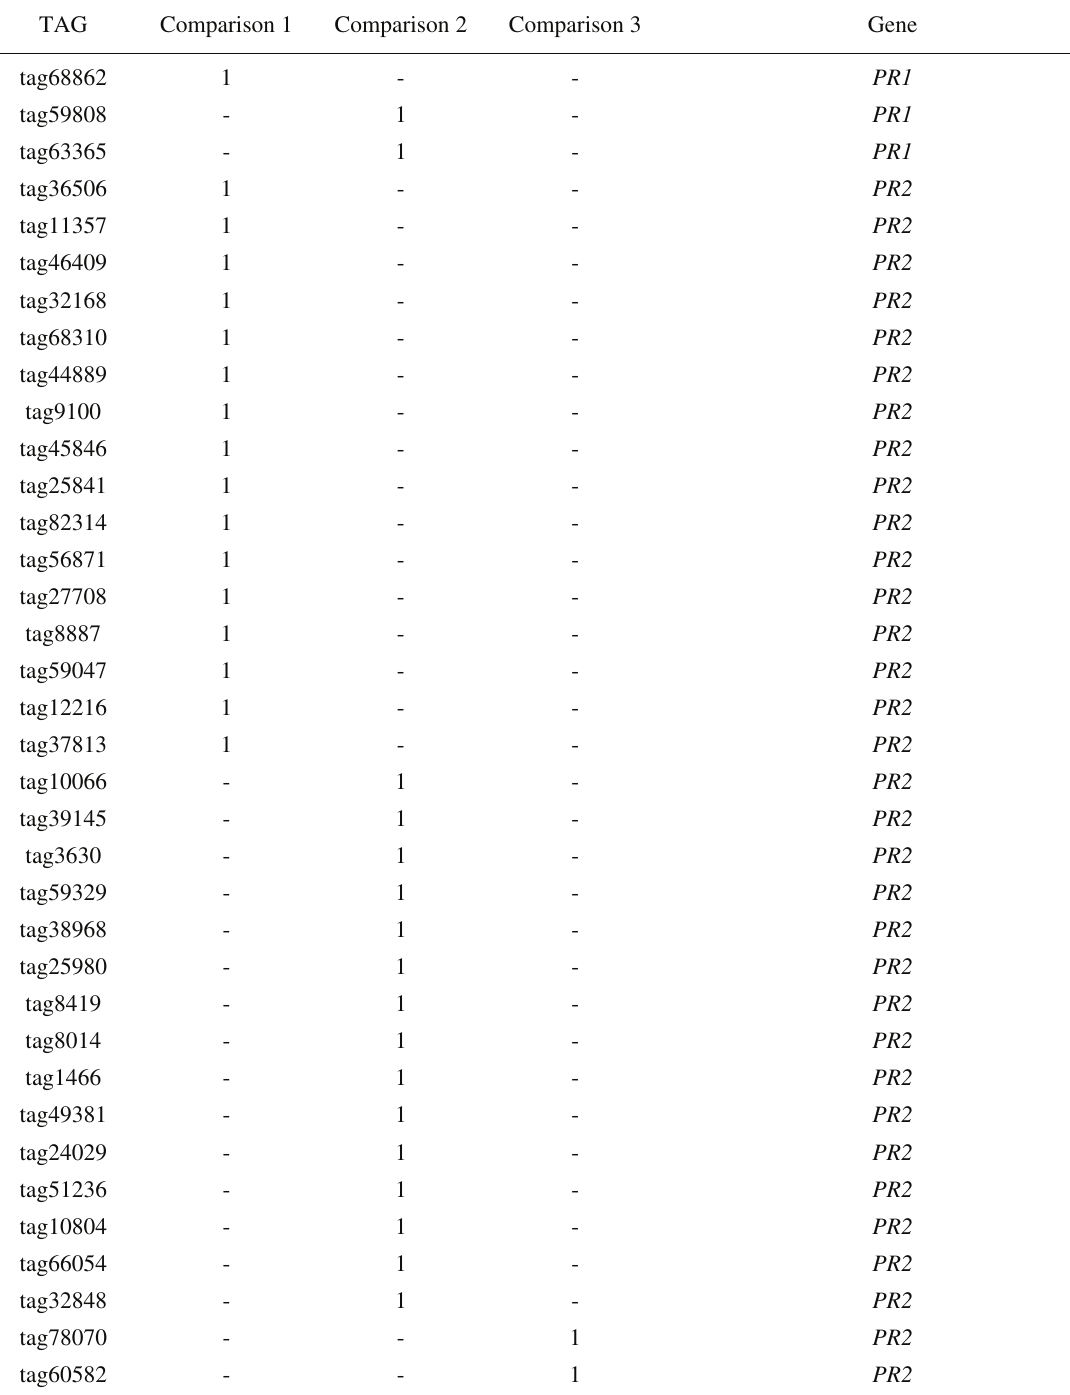
Table S4 - Number of tag and of repetitions in all three comparisons matching R and PR